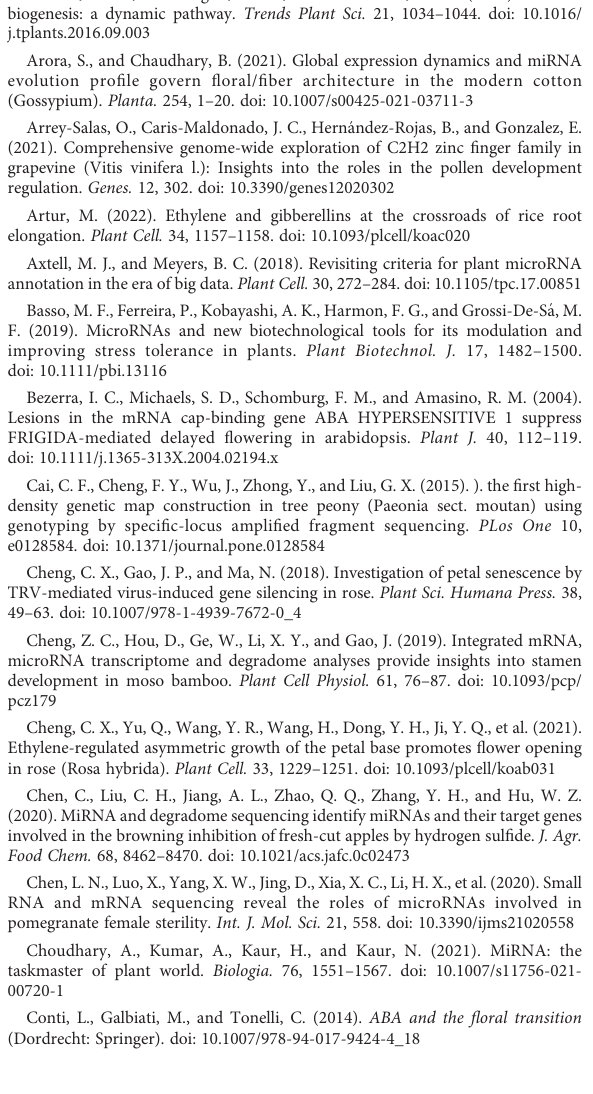
psu.T.00024044 . (C) T plot of PC-5p-564_43386 and psu.T.00034433 . (D) T plot of mtr-miR396b-5p and psu.T.00010381 . (E) T plot of PC-3p-602268_25_S and psu.T.00020538 . (F) T plot of PC-5p-429002_51_S and psu.T.00018467 . (G) T plot of mtr- MIR2592bj-p3 and psu.T.00015108 . (H) T plot of PC-5p-143784_ 277_S and psu.T.00016751 . SUPPLEMENTARY FIGURE 7 Correlation analysis of miRNA and target expression pro fi les between high-throughput sequencing and qRT-PCR. (A) Correlation analysis of psu.T.00024044 with MIR11025-p5 and miR166-5p . (B) Correlation analysis of psu.T.00034433 with PC-5p-564_43386. (C) Correlation analysis of psu.T.00010381 with mtr-miR396b -5p. (D) Correlation analysis of psu.T.00020538 with PC-3p-602268_25 . (E) Correlation analysis of psu.T.00018467 with PC-5p-429002_51 . (F) Correlation analysis of psu.T.00015108 with mtr-MIR2592bj-p3 . (G) Correlation analysis of psu.T.00016751 with PC-5p-143784_277